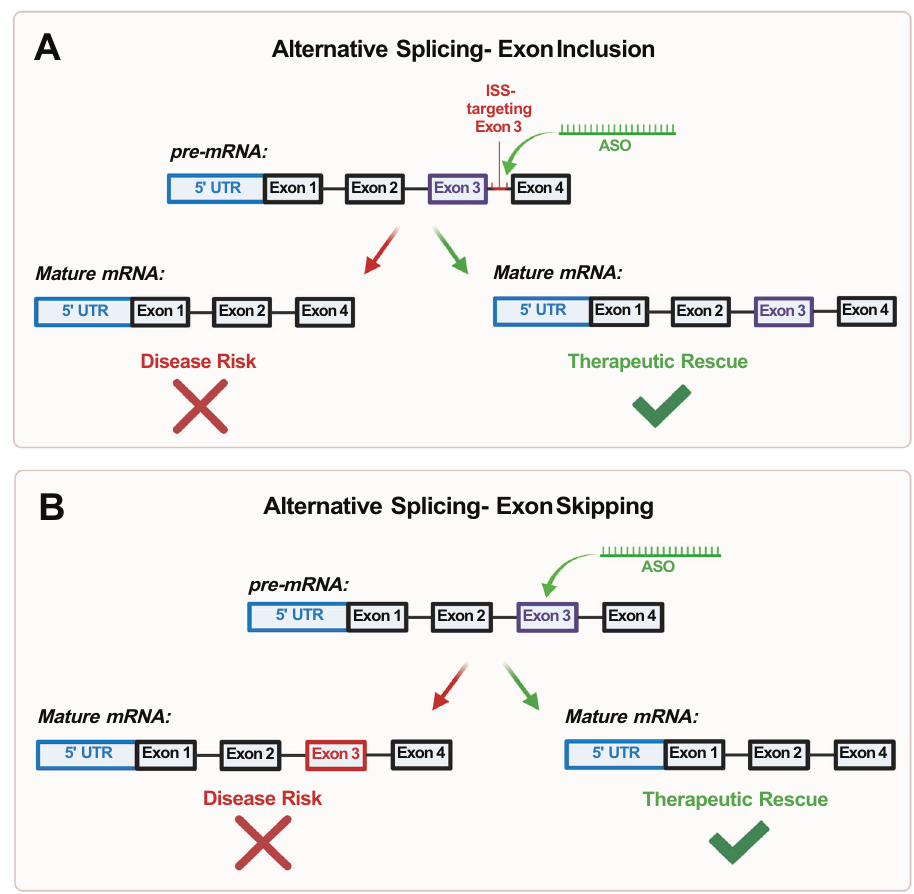
Fig. 4 Diagram of alternative splicing regulation mechanisms by antisense oligonucleotides (ASOs). A Exon inclusion functions through targeting splice junctions and cis -regulatory elements (CRE) as a form of alternative splicing of an mRNA transcript, thus producing a functional copy of the protein. In this example, the ASO targets an intronic splicing silencer (ISS); B Exon skipping is a form of alternative splicing regulation that functions by masking the dysfunctional exon with the ASO — resulting in that exon being spliced out of the fi nal mRNA transcript. This allows for the restoration of the reading frame and translation of a partially functional